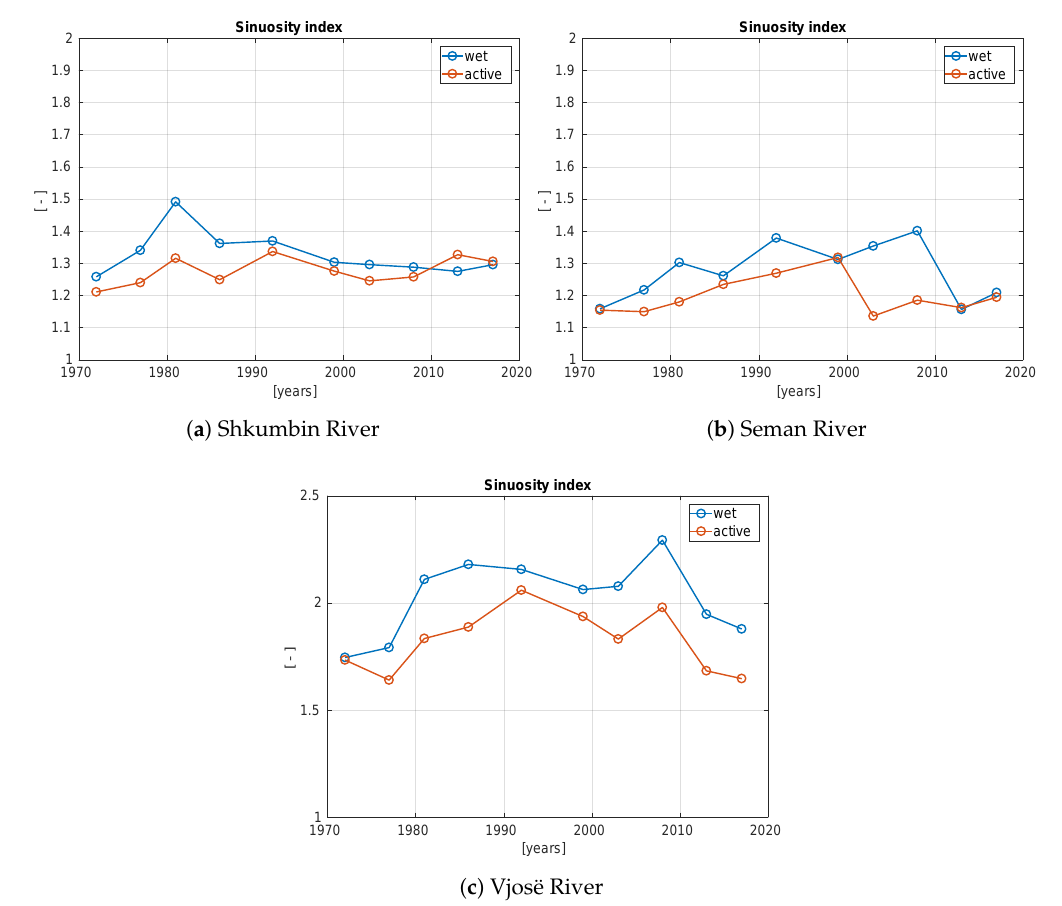
Figure 7. Multi-temporal evolution of the sinuosity indices for the Shkumbin ( a ), Seman ( b ) and Vjosë ( c )